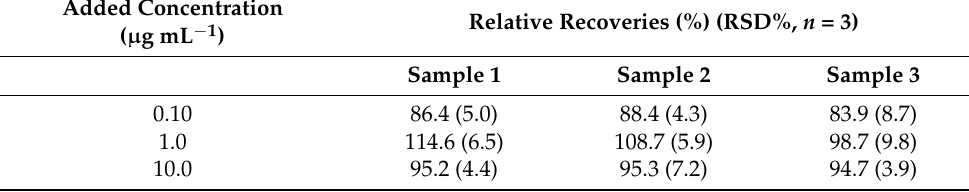
Table 2. Relative recoveries of AMB in human serum samples.